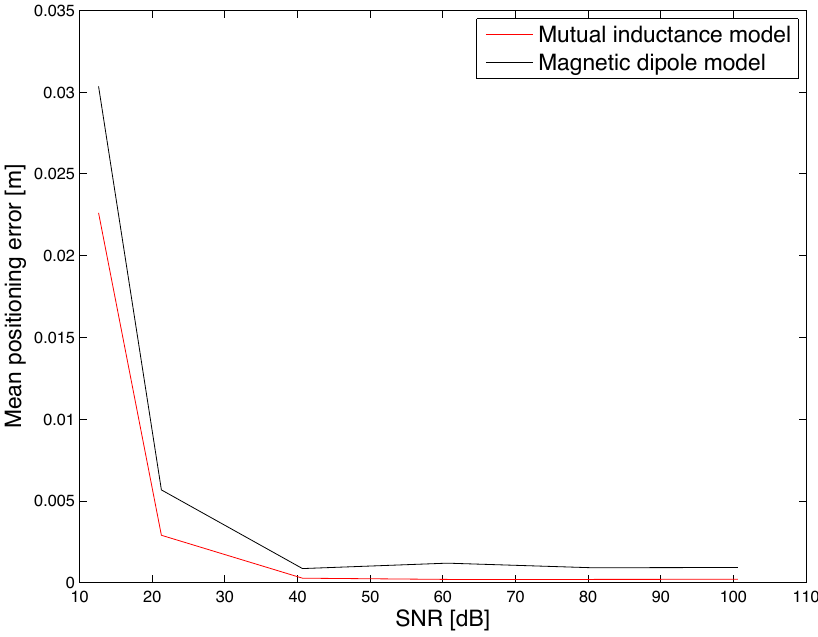
Figure 7. Simulation results: comparison of the mean positioning error obtained for different values of the